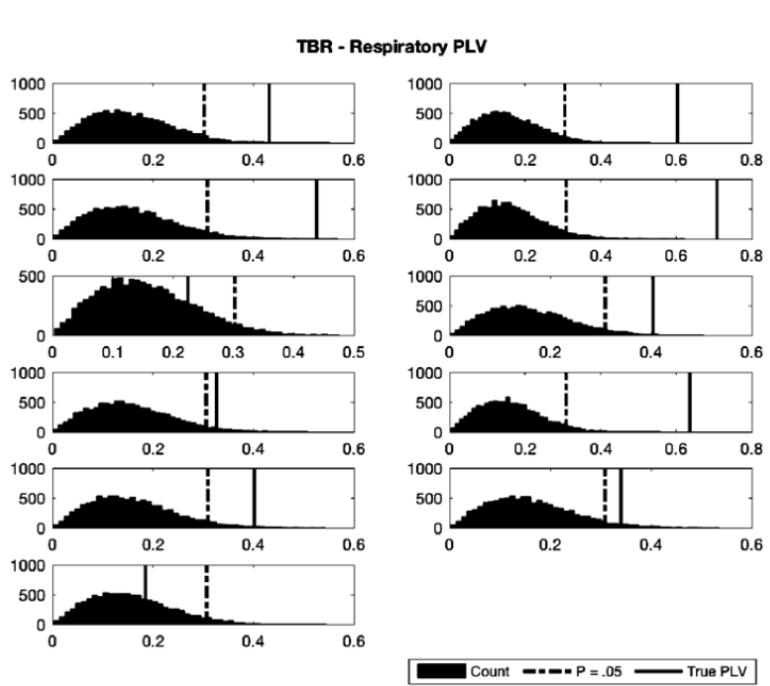
Figure 4. Resampled distributions of TBR-respiratory PLVs for 11 participants. Resampling ( n = 10,000) was carried out with replacement under the null hypothesis of no relationship between TBR and respiratory phase. Black dotted lines indicate critical values of significance ( p = 0.05) and solid black lines indicate true participant PLV. Vertical axes show counts of resampled distributions, horizontal axes show computed p -values. Table 2. Computed p -values of participant PD-Respiratory PLV against resampled (with replace- ment) distributions ( n = 10,000) under the null hypothesis that respiratory phase, which was ran- domized during resampling, bore no relationship to PD. Harmonic Mean p-value ( 𝛲̌ ) was calculated Σ 𝑖=1𝐿 𝑤 𝑖 by the formula . 𝛲̌ = ⁄ , where L is the number of p -values, w i is the i th p -value weight Σ 𝑖=1𝐿 𝑤 /𝑝 𝑖 𝑖 (here all weights were 1/12), and p i is the i th p -value.